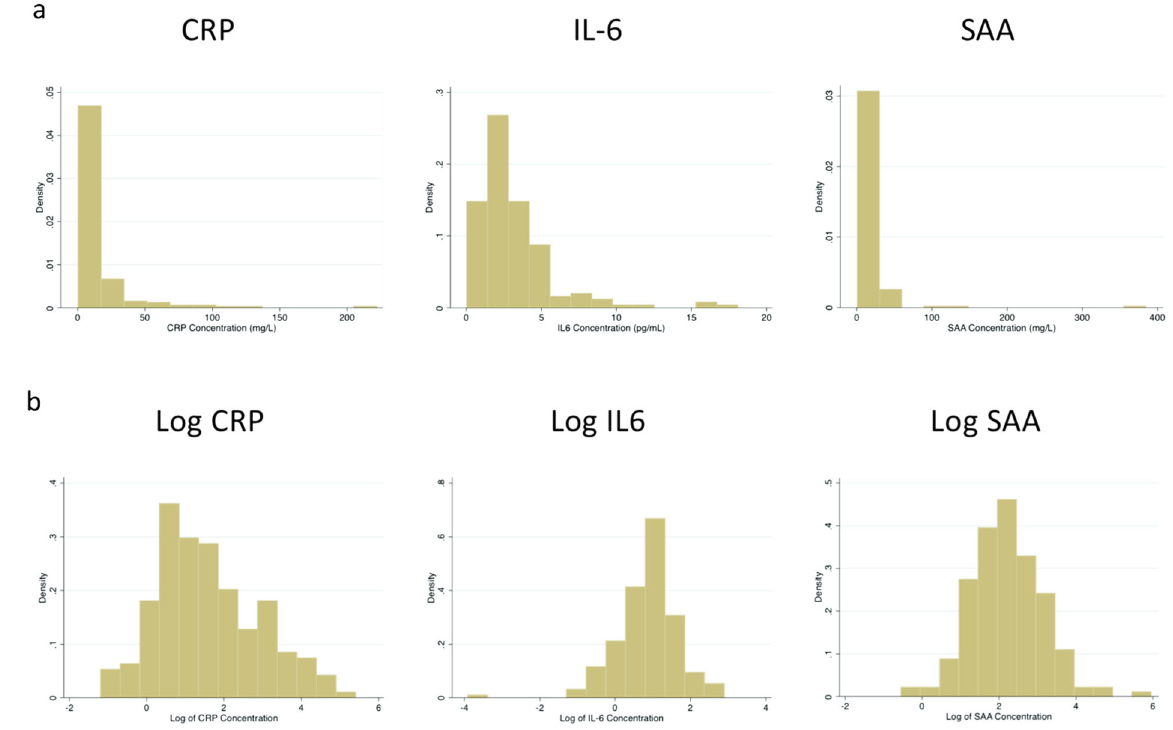
Fig. 1 Biomarker histograms. a Serum biomarker concentrations; b Natural log transformed serum biomarker concentrations.